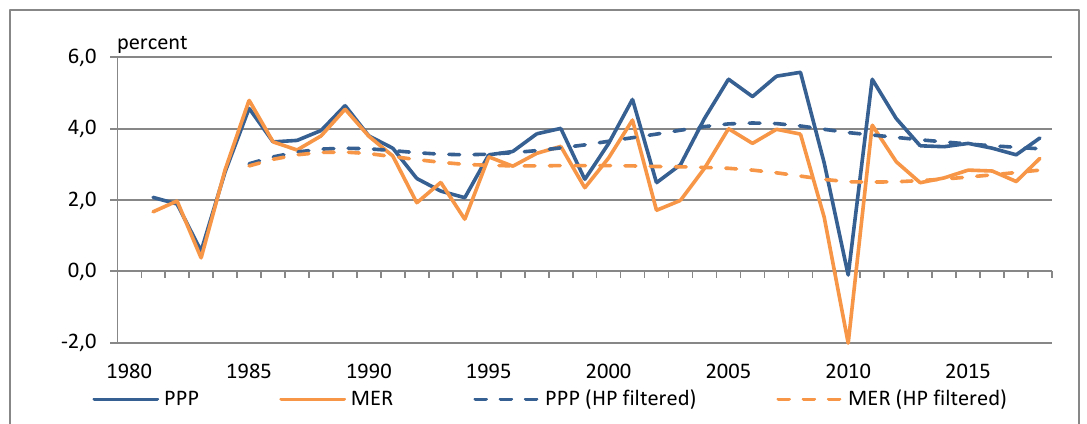
Figure 6: Global output growth